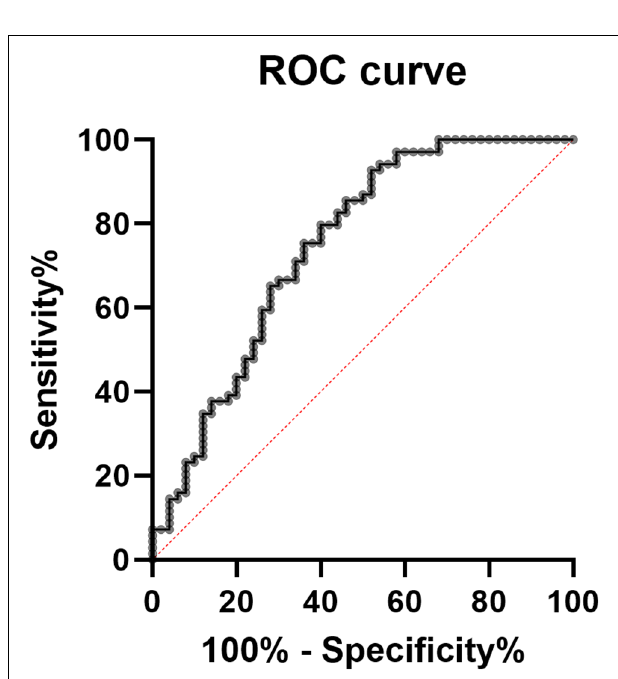
FIGURE 3 | Receiver operating characteristic curve (ROC) based on blood RGS2 mRNA levels; area under the curve (AUC) =